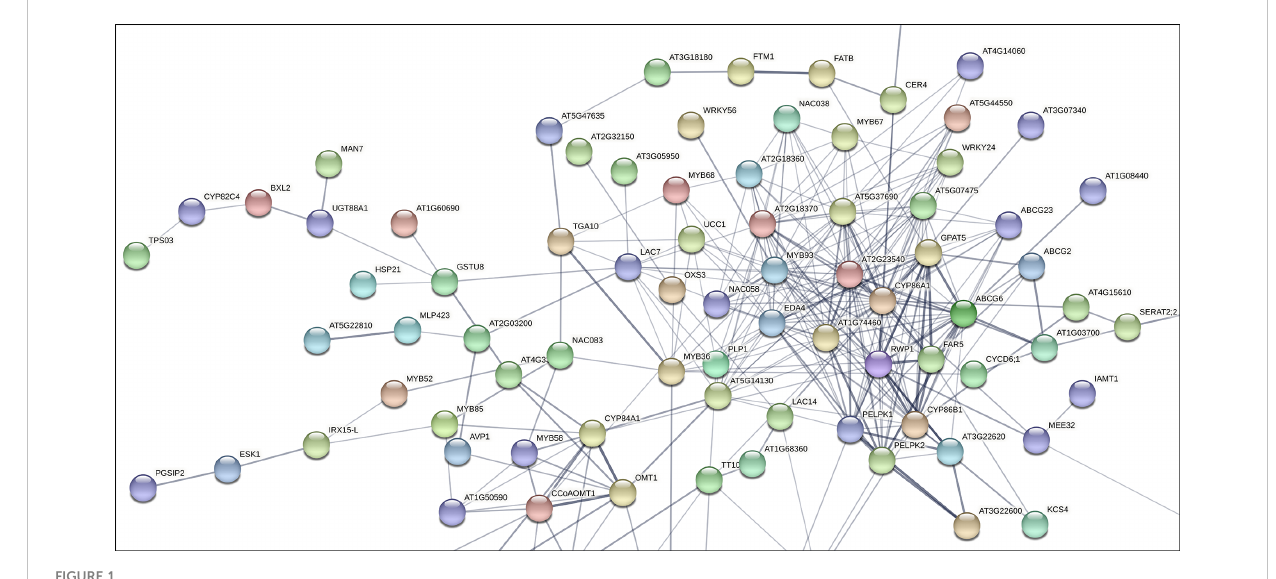
FIGURE 1 Subset of the gene interaction matrix obtained from genes signi fi cantly upregulated in russeted apple fruit skin compared to waxy apples (-3<log 2 ratio (russeted/waxy)<3) (Legay et al., 2015; Andre ́ et al., 2022). Grey lines represent the gene interaction con fi dence (ranged from 0 to 1): thickest lines display con fi dence scores higher than 0.9, thinnest lines display con fi dence scores between 0.4 and 0.7. Node color display the different shell of interactors (from hot colors for the fi rst shells of interactors to cold colors for the last shells). The complete gene interaction map, gene description and associated gene ontology analysis are available in Supplementary Figure 1 and Supplementary Table